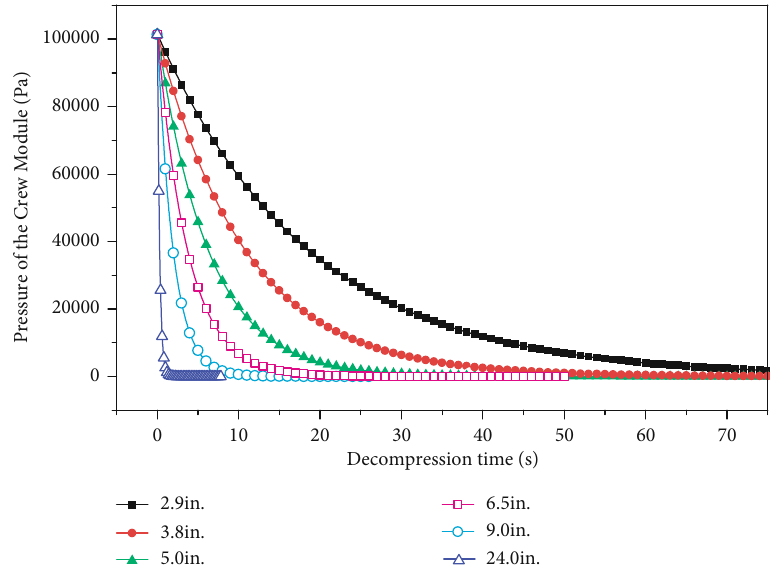
Figure 4: The decompression time under di ff erent hole size for Crew Module.